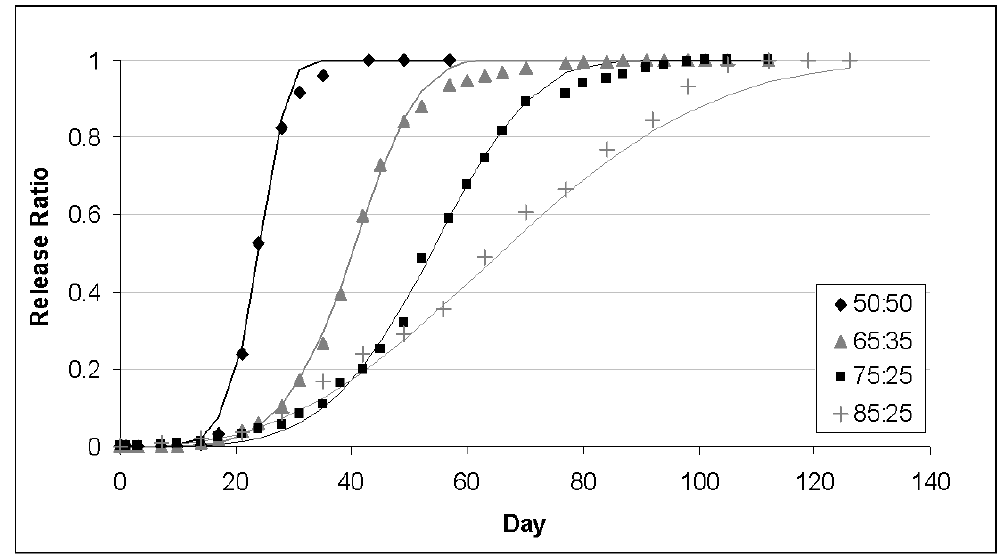
Figure 1: Figure shows modeled in vivo release profiles for 50:50, 65:35, 75:25 and 85:15 poly